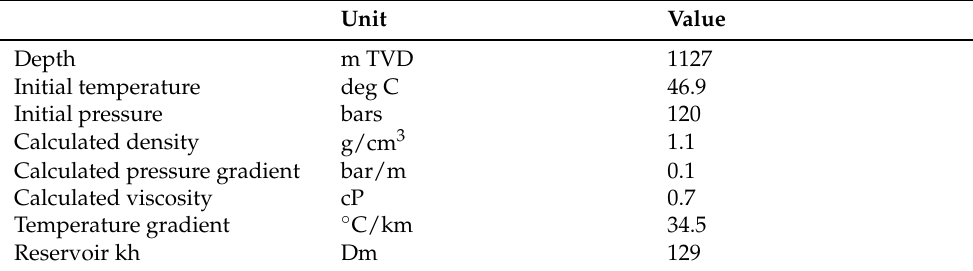
Table 2. Well test data for Sønderborg